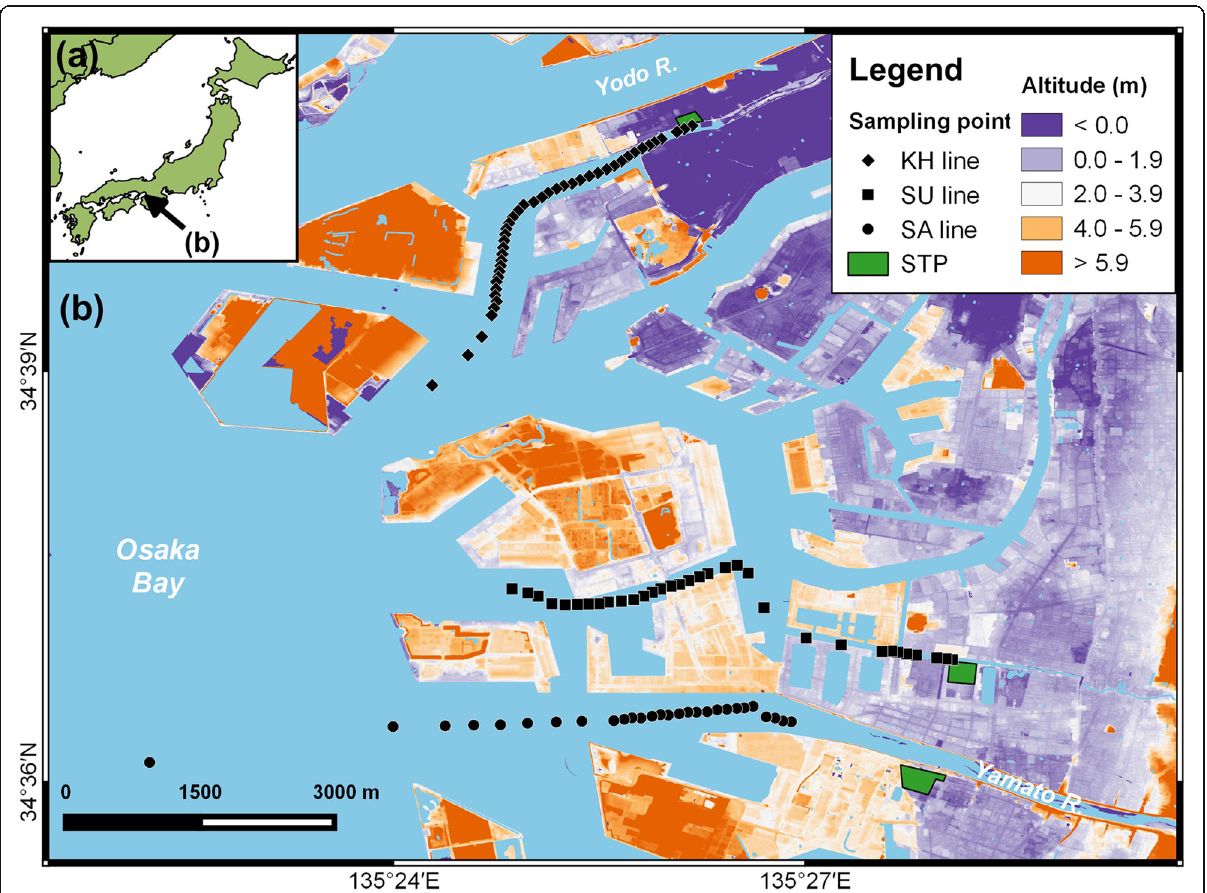
Fig. 1 Map of the study area ( a location of the study area, b locations of seawater sampling points on the KH, SU and SA lines and the